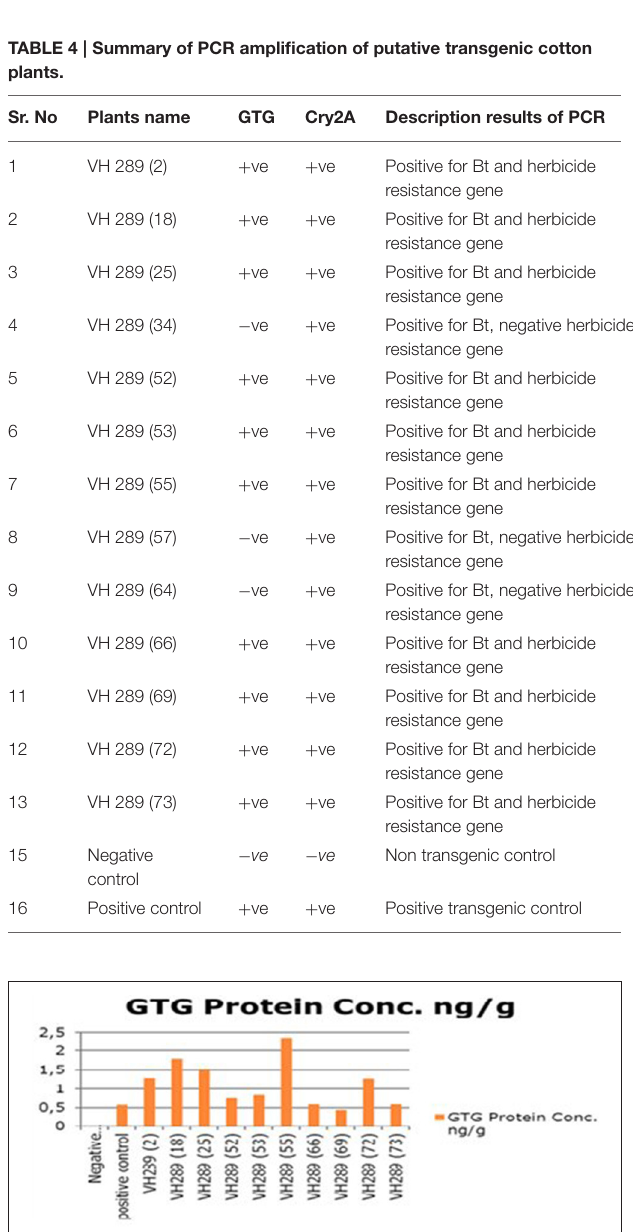
FIGURE 6 | Concentration of GTG protein of transgenic cotton plants at T 0 generation. Lane 1 represents control cotton plant; Lane 2 shows positive control; Lane 3–12 represent cotton plants.